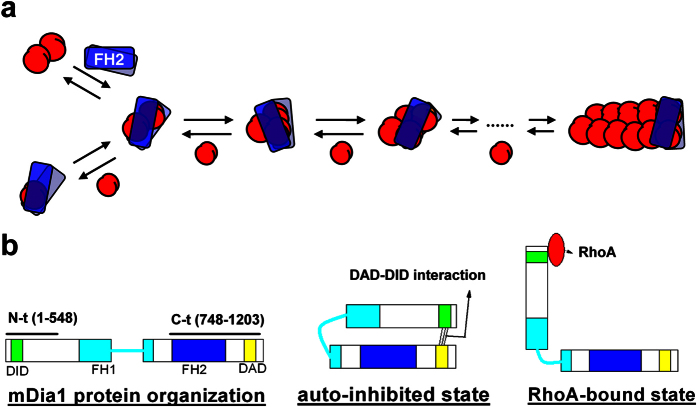
Formin function and regulation.(a) The FH2 domain of formin stabilizes actin nuclei (red) and continuously binds to the barbed end of actin filaments while allowing the addition of new actin monomer to the barbed end (modified from cited ref. 8). (b) Organization and regulation of mDia1 protein domains. Lines above the left-most diagram represent the constructs used in this study: mDia1 N-t and mDia1 C-t, with the starting and ending amino acids specified. The active FH2 domain is auto-inhibited by the DAD-DID interaction, which is relieved when RhoA binds to the N-terminus to compete with DAD (modified from cited ref. 4).